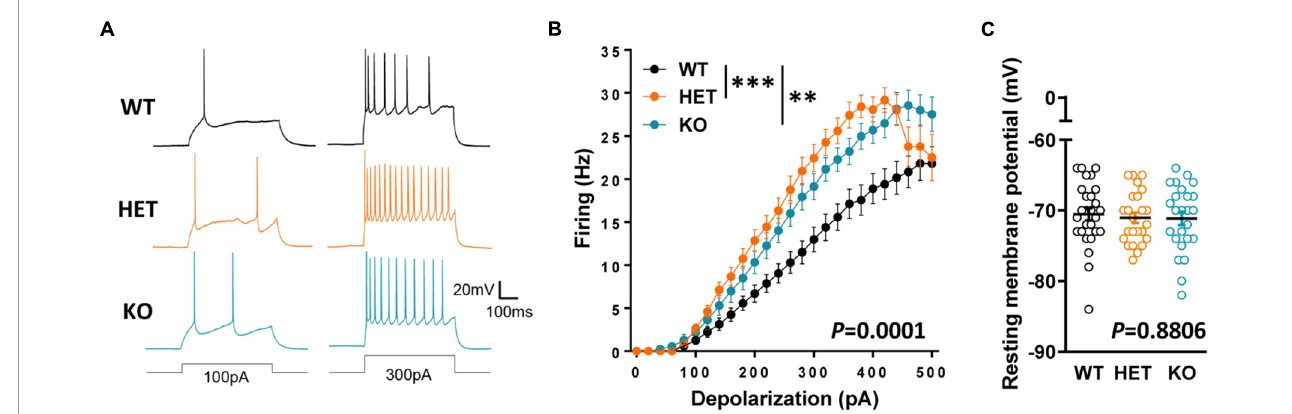
FIGURE7 Intrinsic excitability in cortical pyramidal cells from P10–P12 pups. Sample spike trains evoked by a 100-pA (left) or a 300-pA somatic current injection (right) in a WT (top), HET (middle) and KO (bottom) neuron (A) . Mean f-i curve for WT ( n = 27 cells from three mice), HET ( n = 24 cells from three mice), and KO ( n = 27 cells from three mice) (B) . Resting membrane potential of the recorded neurons (C) . Statistical tests: (B) Two-way RM ANOVA followed by Sidak’s post-hoc test; (C) One-way ANOVA to compare the three genotypes; ∗∗ P < 0.01, ∗∗∗ P < 0.001.